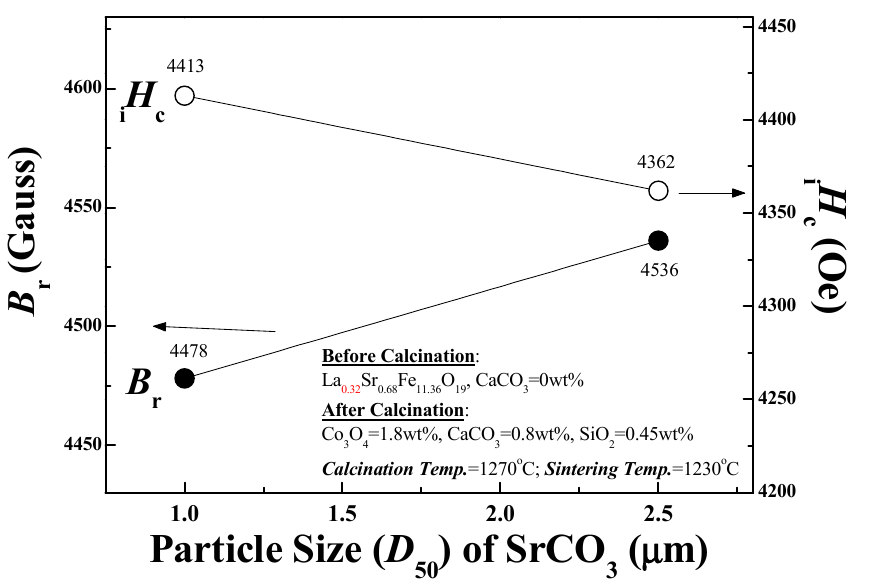
Figure 6. Magnetic properties of Sr ferrite with different particle sizes of raw material SrCO 3 .